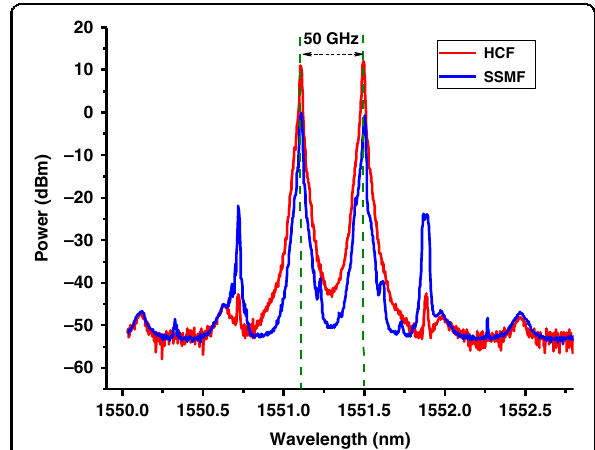
Fig. 8 The measured SFDR3 of the noise fi gure optimized HCF (squares) and SSMF (triangles) APLs. For the HCF APL, the SFDR3 with the HCF replaced by an attenuator (back-to-back) is also shown (circles), con fi rming there is no degradation in the APL